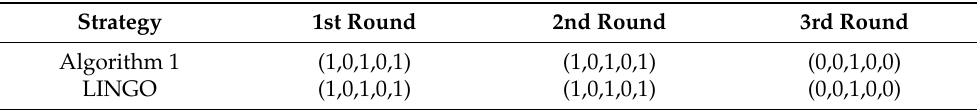
Table 5. Comparison of Algorithm 1 and